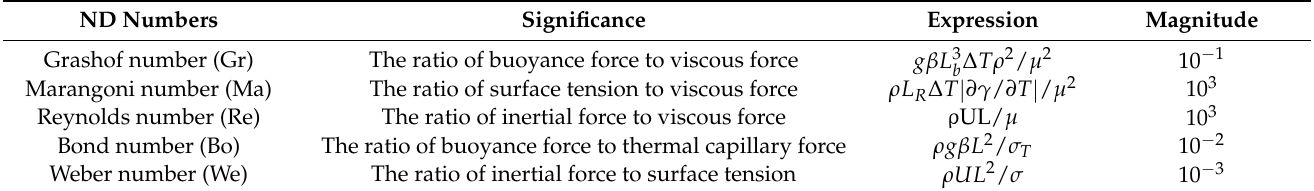
Table 5. ND numbers used to study the driving force in L-DED